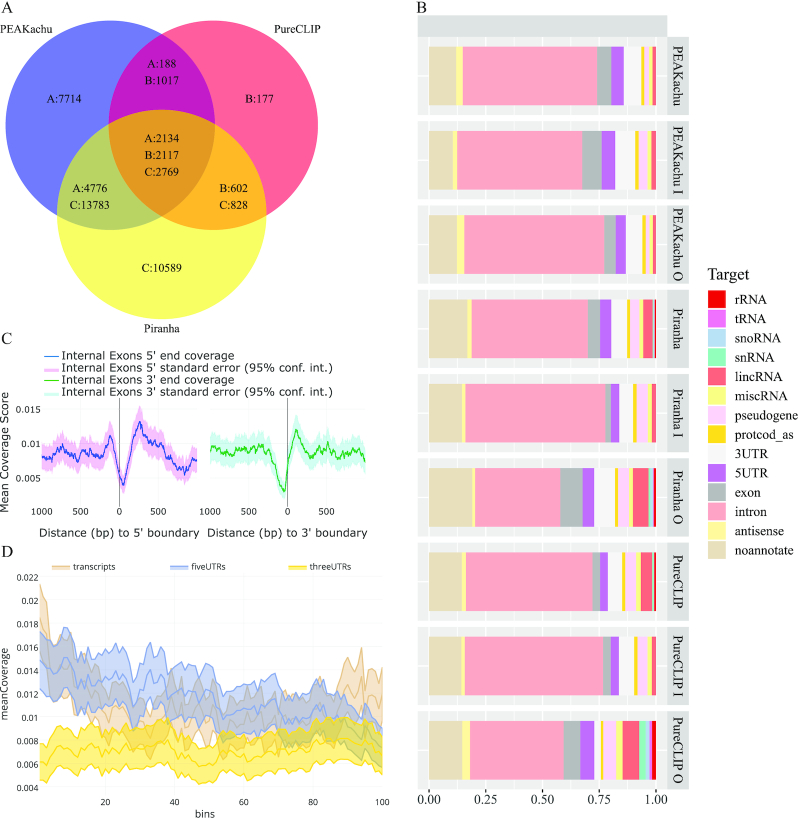
Comparison and analysis of the binding regions detected by PEAKachu (A), Piranha (B), and PureCLIP (C). The results are from the eCLIP data of RBFOX2 [13]. (A) We intersected the binding regions identified by the peak callers with bedtools [40], paying attention to the strand (intersect “-s"), to assess the robustness of each method. (B) We then annotated the binding regions of each peak caller and plotted the fraction of each target. We also analyzed separately the peak set of the individual peak callers (O = peak set 7,714/177/10,589) and the peak set of the intersection with all peak callers (I = peak set 2,134/2,117/2,769). RBFOX2 prevalently binds introns, but also 3′ and 5′ UTRs as well as lincRNAs. The plot was generated with the hg19 script of targetdist [46]. Investigating the mean coverage of these binding regions identified by (C) PEAKachu [20] reveals an occupancy drop around the 5′ and 3′ ends of the exons. (D) Looking further at the mean coverage of the binding regions identified by PEAKachu in the overall transcript as well as for the 5′ and 3′ UTRs. The thickness of the ribbon around the mean coverage indicates the \documentclass[12pt]{minimal}
\usepackage{amsmath}
\usepackage{wasysym}
\usepackage{amsfonts}
\usepackage{amssymb}
\usepackage{amsbsy}
\usepackage{upgreek}
\usepackage{mathrsfs}
\setlength{\oddsidemargin}{-69pt}
\begin{document}
}{}$95\%$\end{document} confidence interval (mean ± standard error of the mean × 1.96). Each feature is divided into 100 bins of equal length, whereas features smaller than 100 bp are excluded [42]. lincRNA: long noncoding RNA; rRNA: ribosomal RNA; snRNA: small nuclear RNA; snoRNA: small nucleolar RNA; tRNA: transfer RNA.